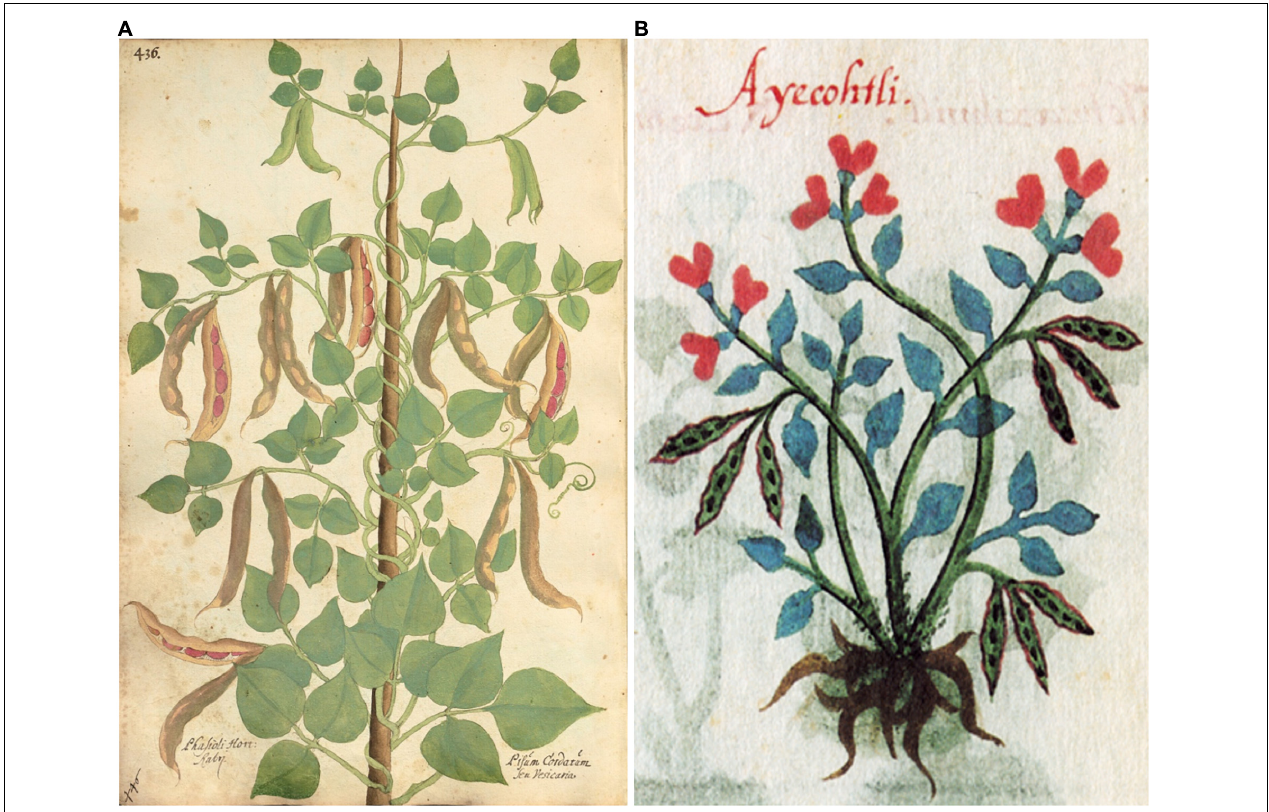
FIGURE 10 | Woodcuts of Phaseolus beans from 16th century herbals and manuscripts. (A) Oellinger (1553), Magnarum Medicinae partium herbariae ... , Folio 436, Phasioli hort ( Phaseolus vulgaris ). This illustration shows a red-brown seed and may represent the seed color of the original specimen. Source: Public domain;